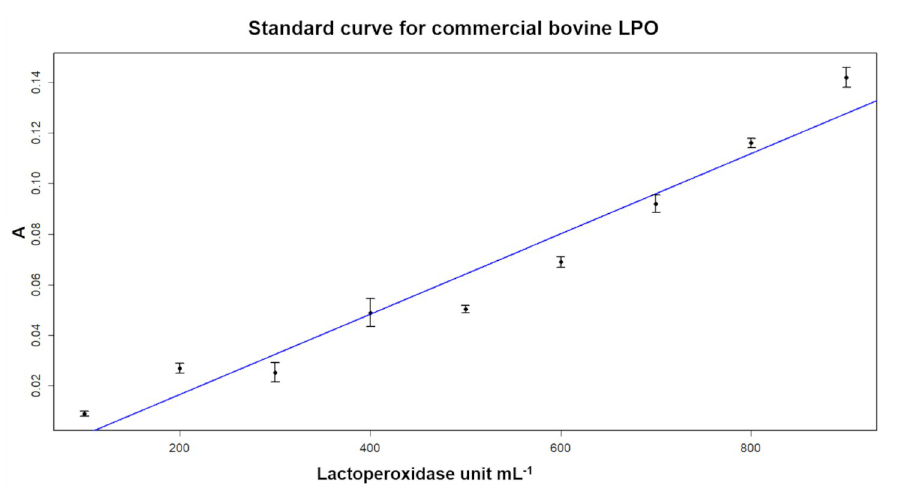
Fig 3. LPO calibration curve in units mL -1 . Calibration curve for lactoperoxidase analysis showing the absorbance vs lactoperoxidase concentration. Adjusted R 2 = 0.98.